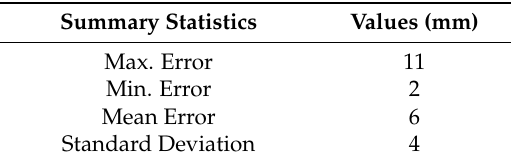
Table 2. Summary statistics of the georeferencing residuals.